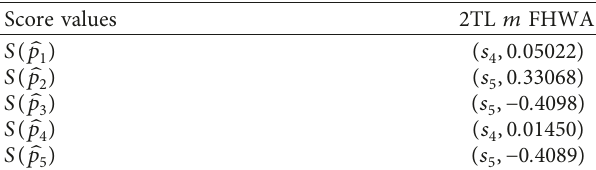
Table 7: Alternative ranking order. i .